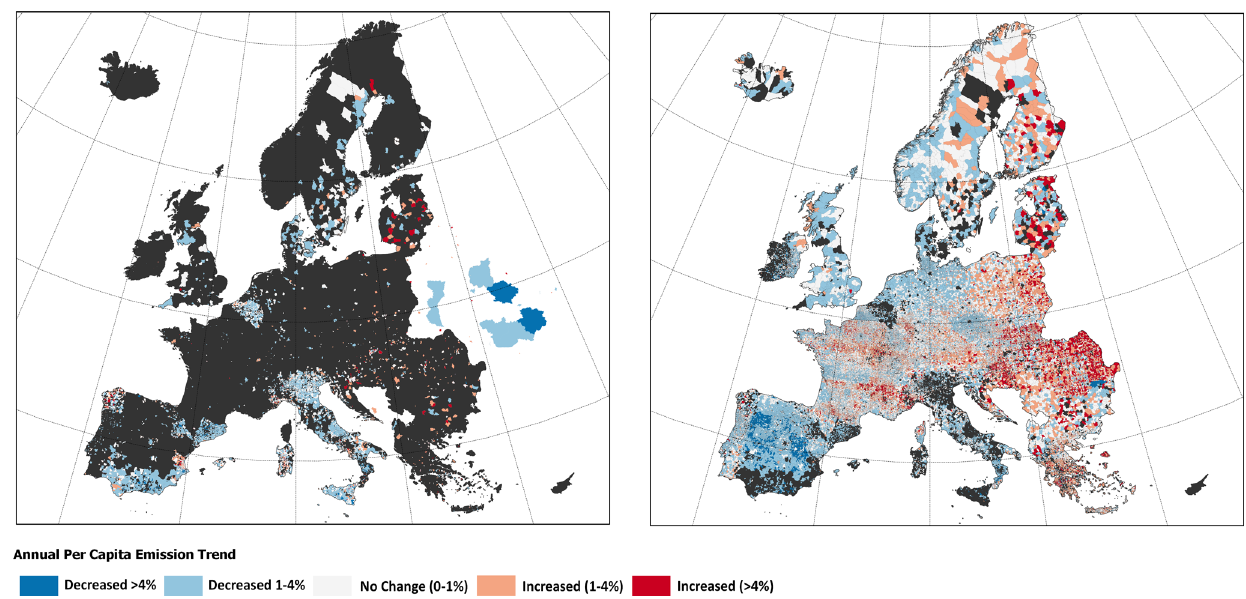
Fig.5|MapsofEuropeancities ’ emissionstrends. Annualpercapitaemissionsreductiontrendfrom2001to2018forcitiesparticipatingintheEUCoM(left)andallother external cities